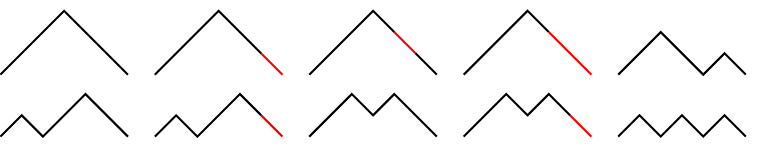
Figure 3: All 10 skew Dyck paths of length 6 (consisting of 6 steps).